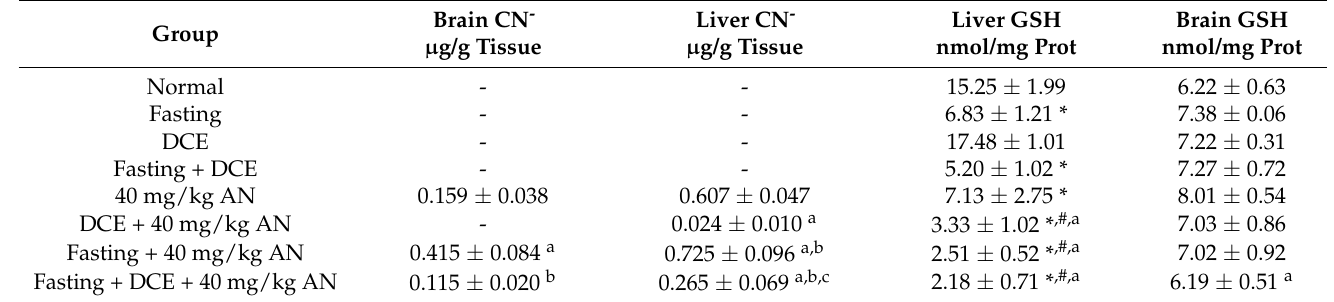
Table 3. Effects of fasting and DCE on tissue cyanide (CN - ) concentrations and GSH in mice treated with